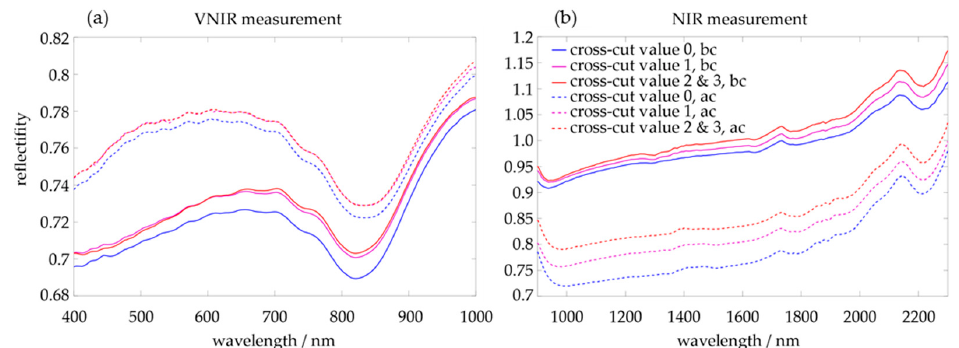
Figure 5. ( a ) Mean value spectra of the VNIR- HSI measurement for each of the three cross-cut classes of the samples before cleaning (bc) and after cleaning (ac); ( b ) Mean value spectra of the NIR-HSI measurement for each of the three cross-cut classes of the samples before cleaning (bc) and after cleaning (ac).